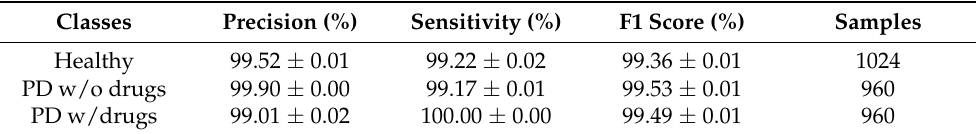
Table 6. Multiclass performance values for each class in Experiment 1. Drugs refer to the dopaminer- gic medications taken by PD patients.